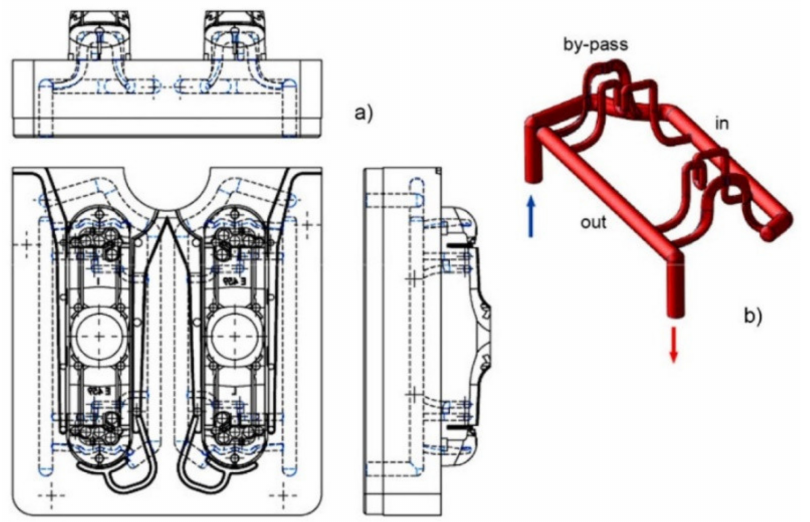
Figure 25. Redesigned impression block, a die for zinc alloy castings, with conformal cooling channels [136]. ( a ) The impression block. ( b ) The conformal cooling channels inside the impression block. See also Figure 24.